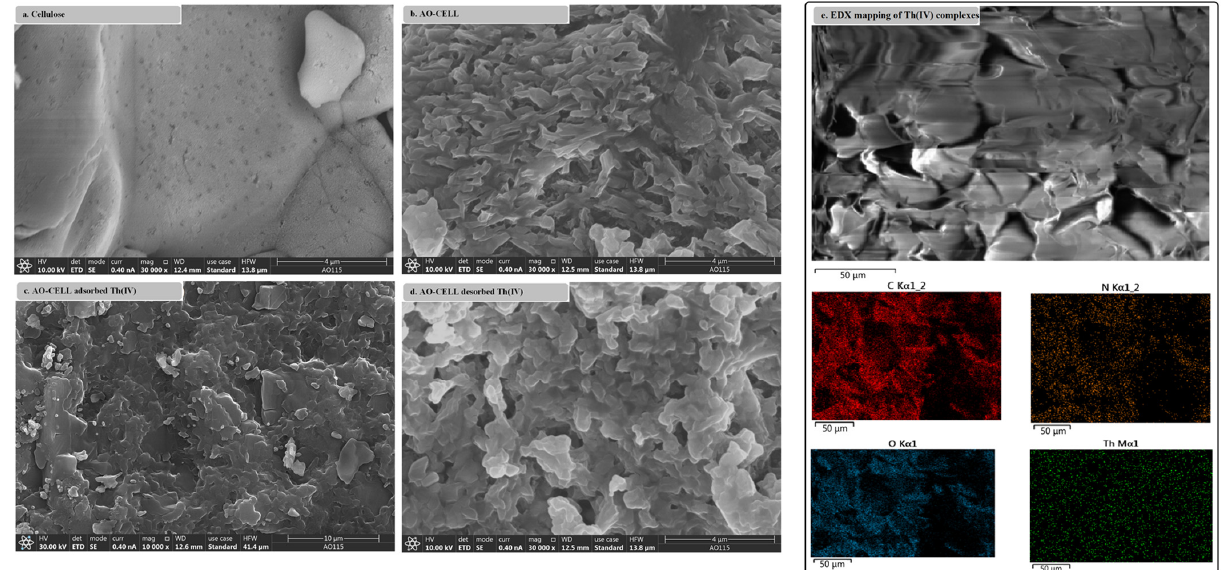
Figure 2. SEM of cellulose its derivatives. ( a ) Cellulose; ( b ) AO-CELL; ( c ) AO-CELL adsorbed Th(IV); ( d ) AO-CELL desorbed Th(IV); ( e ) EDS mapping of Th(IV)